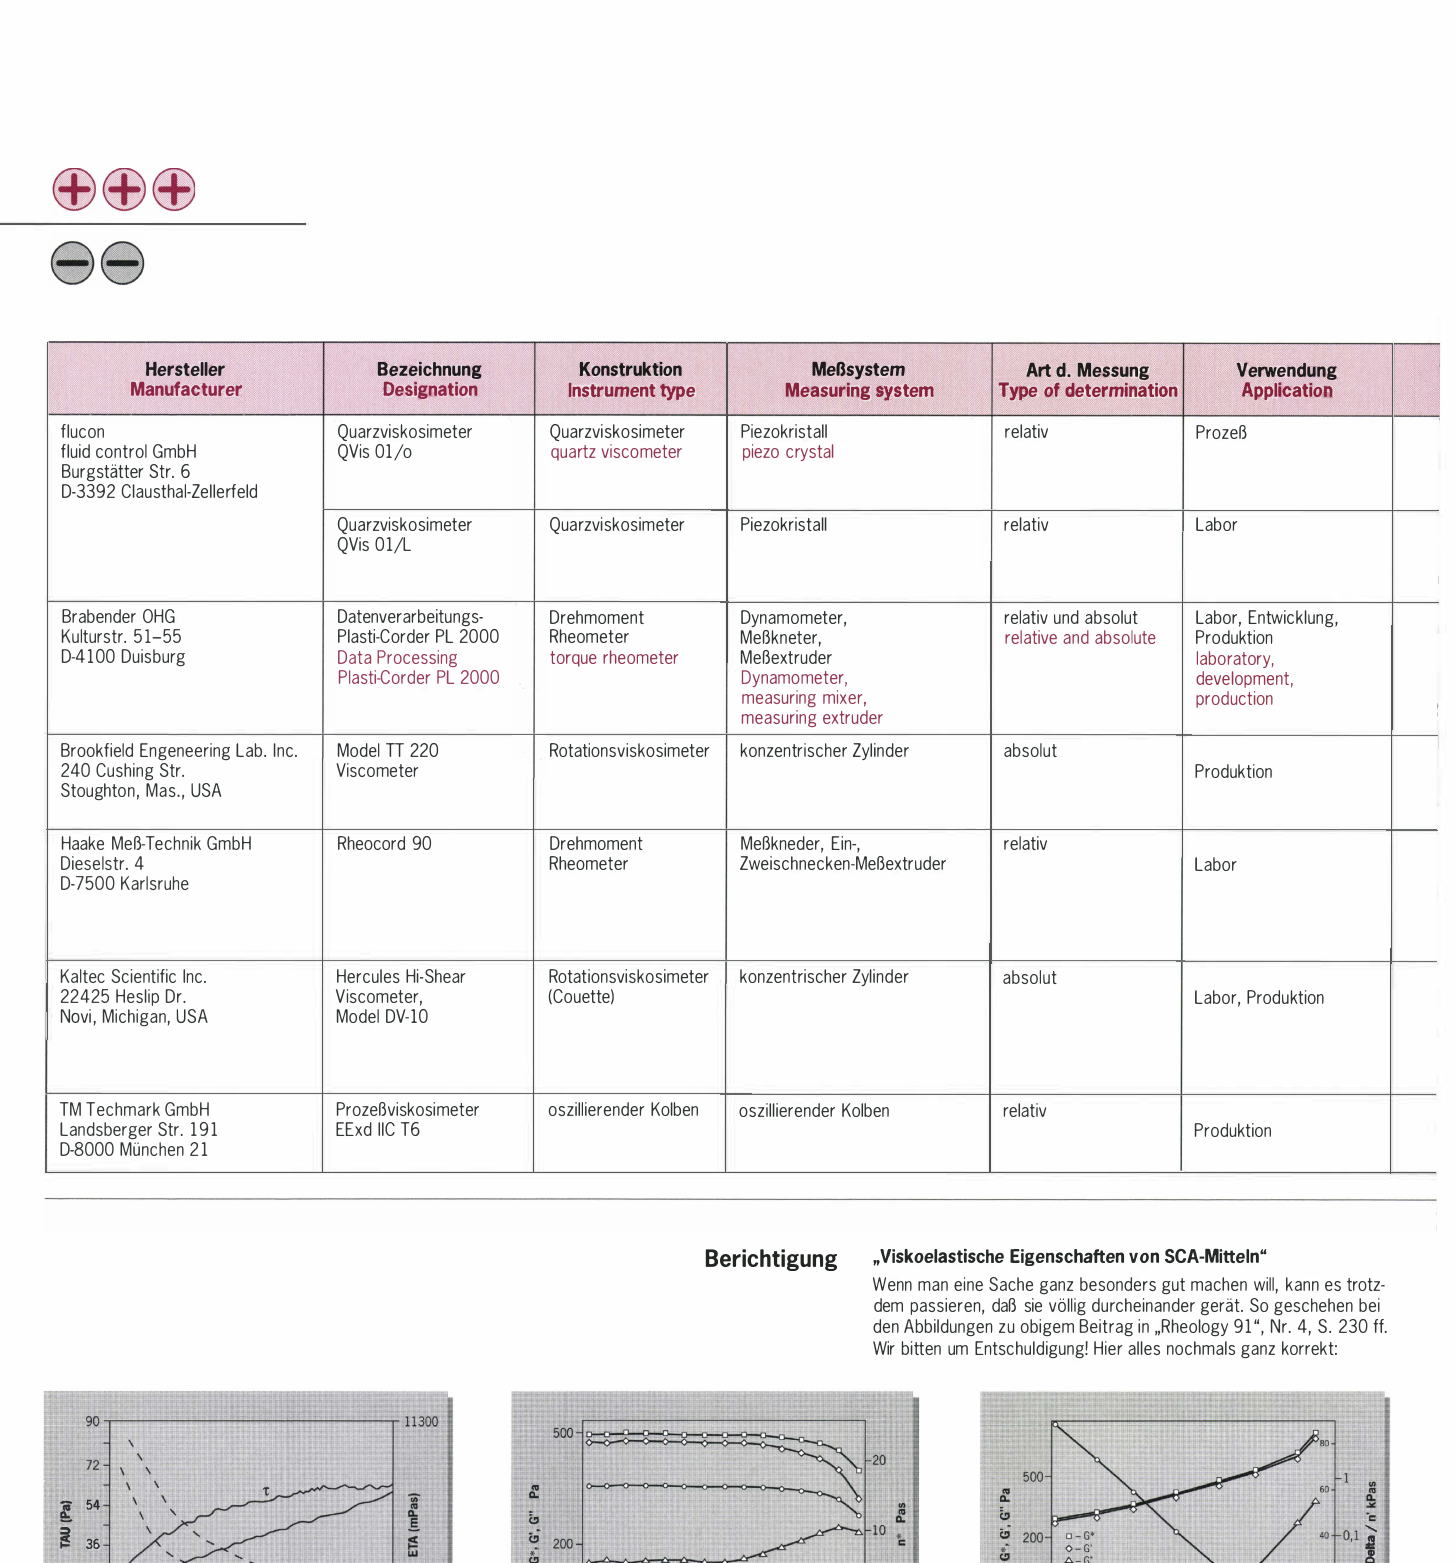
Abb. 1: Flie/Jkurve der Probe A bei T =20 oc Fig. 1: Flow curve for sample A at 20 oc